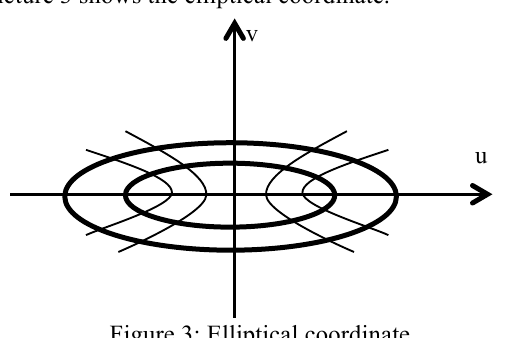
Figure 3: Elliptical coordinate.